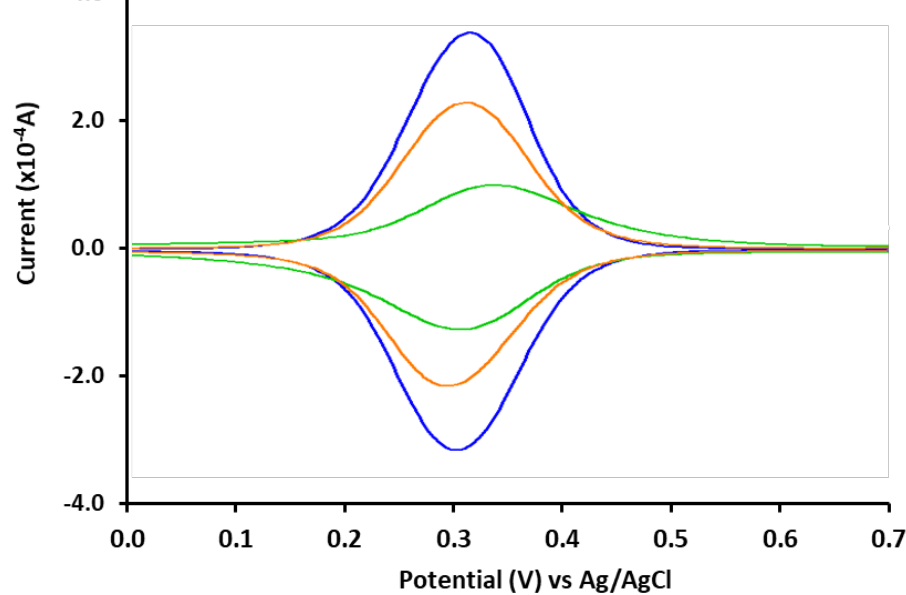
Figure 9. Square wave voltammogram (SWV): oxidation and reduction signals of the gold electrode (blue), after modification with DTT COOH (green), and after modification with aptamer (orange). All experiments were carried out using a three-electrode setup with a gold electrode, a Pt wire, and Ag/AgCl electrode as the working electrode, the auxiliary electrode, and the reference electrode, respectively, in 5 mM [Fe(CN) 6 ] 3 − /4 − as the redox probe containing 0.5 M KCl as the supporting electrolyte. The SWV experiments were performed with an amplitude of 2.5 mV, a frequency of 15 Hz, and a 2 sec quit time.